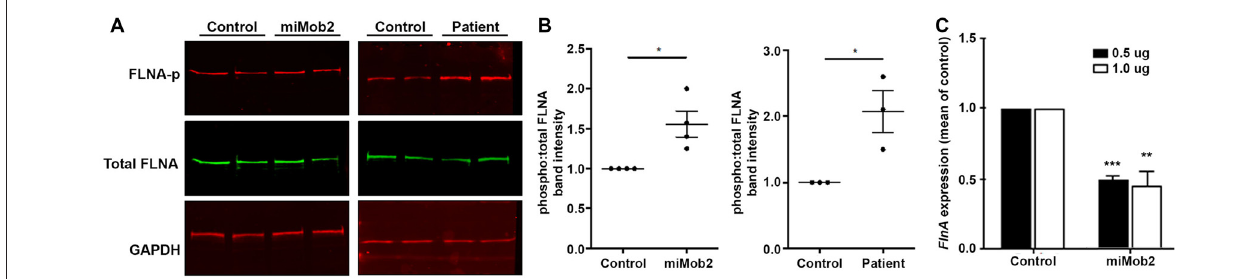
FIGURE 4 | Mob2 knockdown increases FlnA phosphorylation at Ser 2152 in vitro . (A) C2C12 cells were transiently transfected with EGFP/empty vector control or miRNAs targeting Mob2 (left panel). At 24 h after transfection, cell lysates were prepared and subjected to Western blot analysis using the indicated antibodies. Right panel shows results for the same experiment but performed on age-matched control or patient 1203 fibroblasts. (B) Quantifications representing three biological replicates of (A) summarizing the proportion of phosphorylated Flna at residue 2152 relative to total FLNA and normalized against the loading control Gapdh in C2C12 or age-matched fibroblast controls. Results represented as mean ( ± SEM). (C) Mean ( ± SEM) FlnA expression in C2C12 cells expressing control or Mob2 targeting hairpins at the indicated amounts. Expression was normalized against the control using the delta-delta Ct method, as determined by real-time PCR.